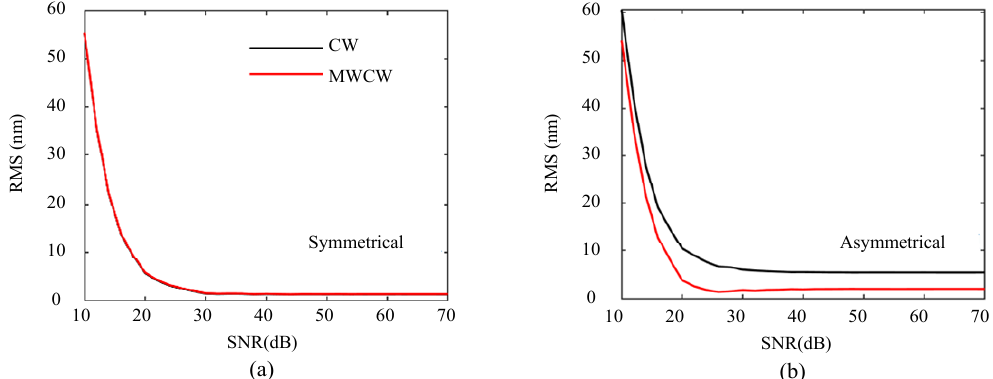
Fig. 9 Impact of detection noise on performance of two methods when used for (a) symmetrical and (b) asymmetrical S ( 